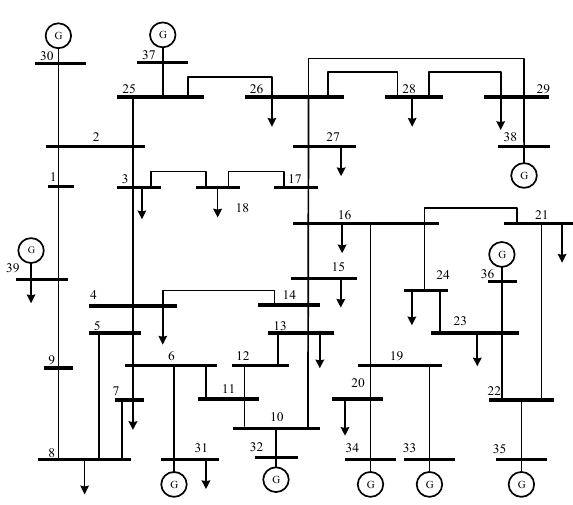
Figure 3. Topology of the IEEE 39-bus system.